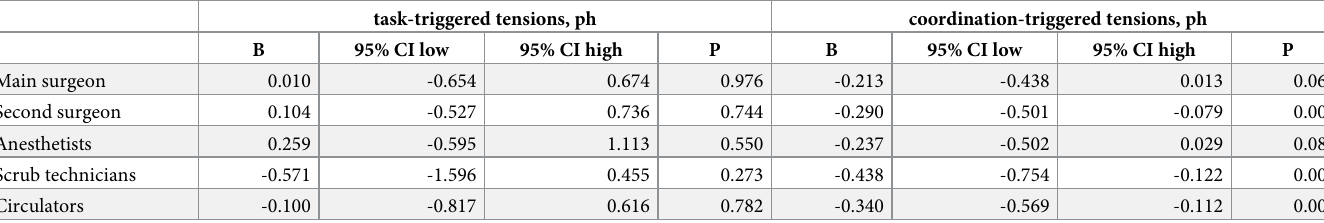
Table 6. Effects of task- and coordination-triggered tensions on quality of teamwork within the team. task-triggered tensions, ph coordination-triggered tensions,